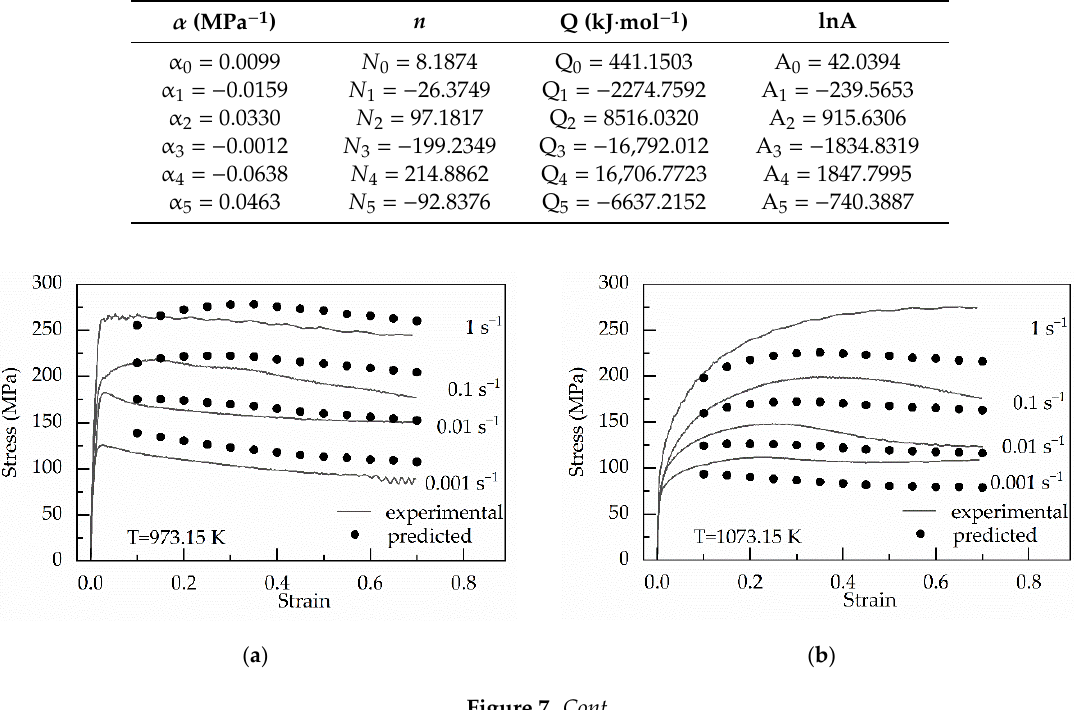
Figure 6. Relationship between the strain and material constants in the osA-type equation. ( a ) α ; ( b ) n ; ( c ) Q; ( d ) A. Table 2. Coefficients of the polynomial for α , n , Q and lnA in the osA-type equation.